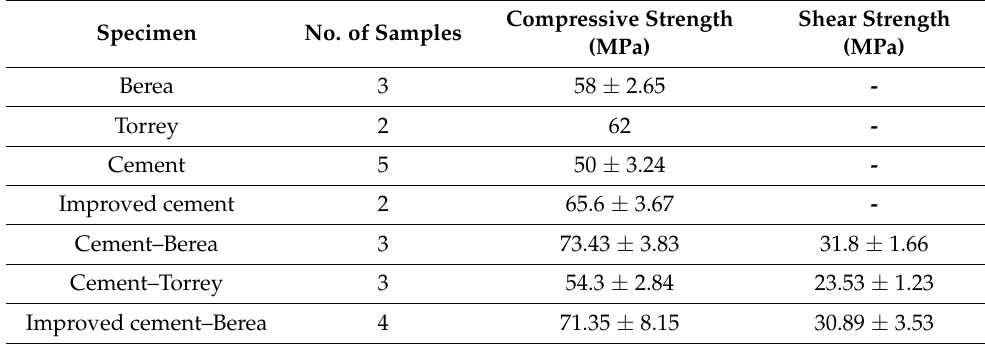
Table 3. The mean compressive and shear bond strength of cement, formation, and composite cement–formation specimens at a confining pressure of 10